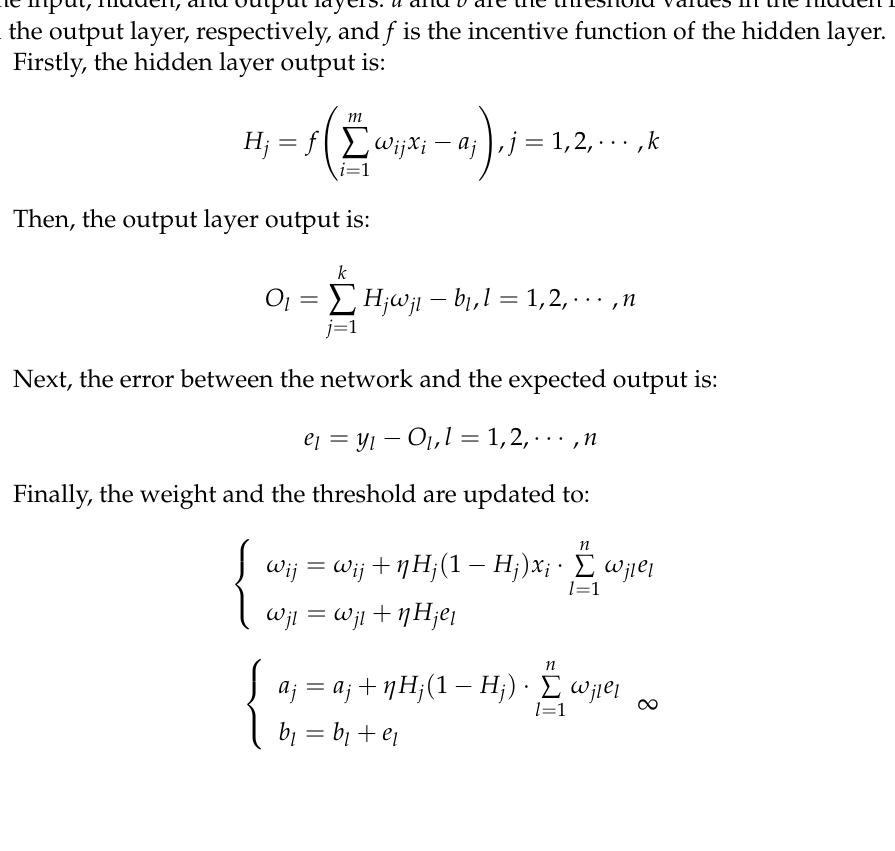
Figure 5. The topology of the BP network.